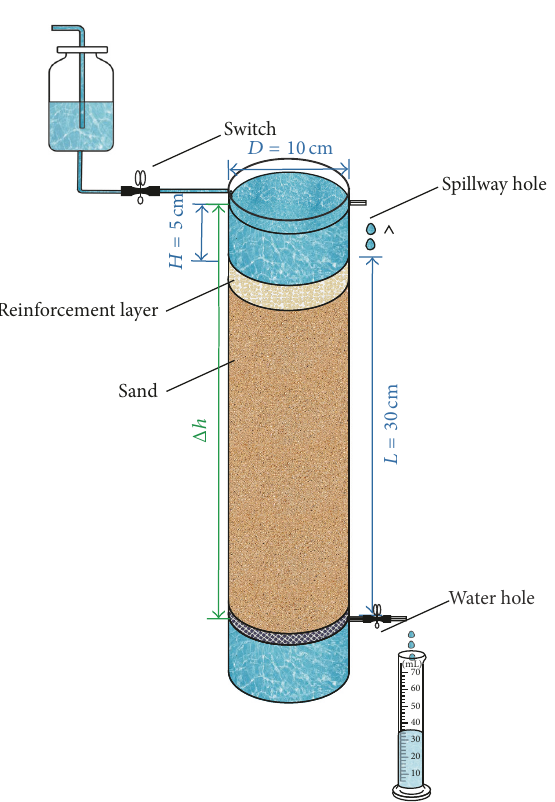
Figure 3: TST-70 permeameter used in single-hole permeability